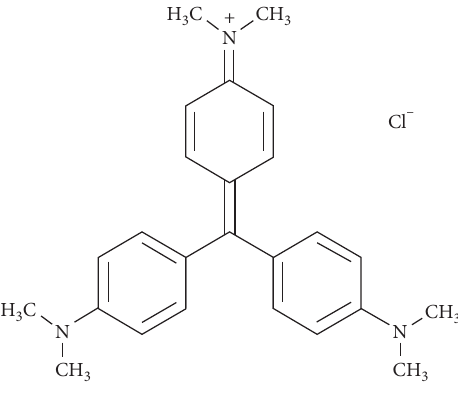
Figure 1: Structure of crystal